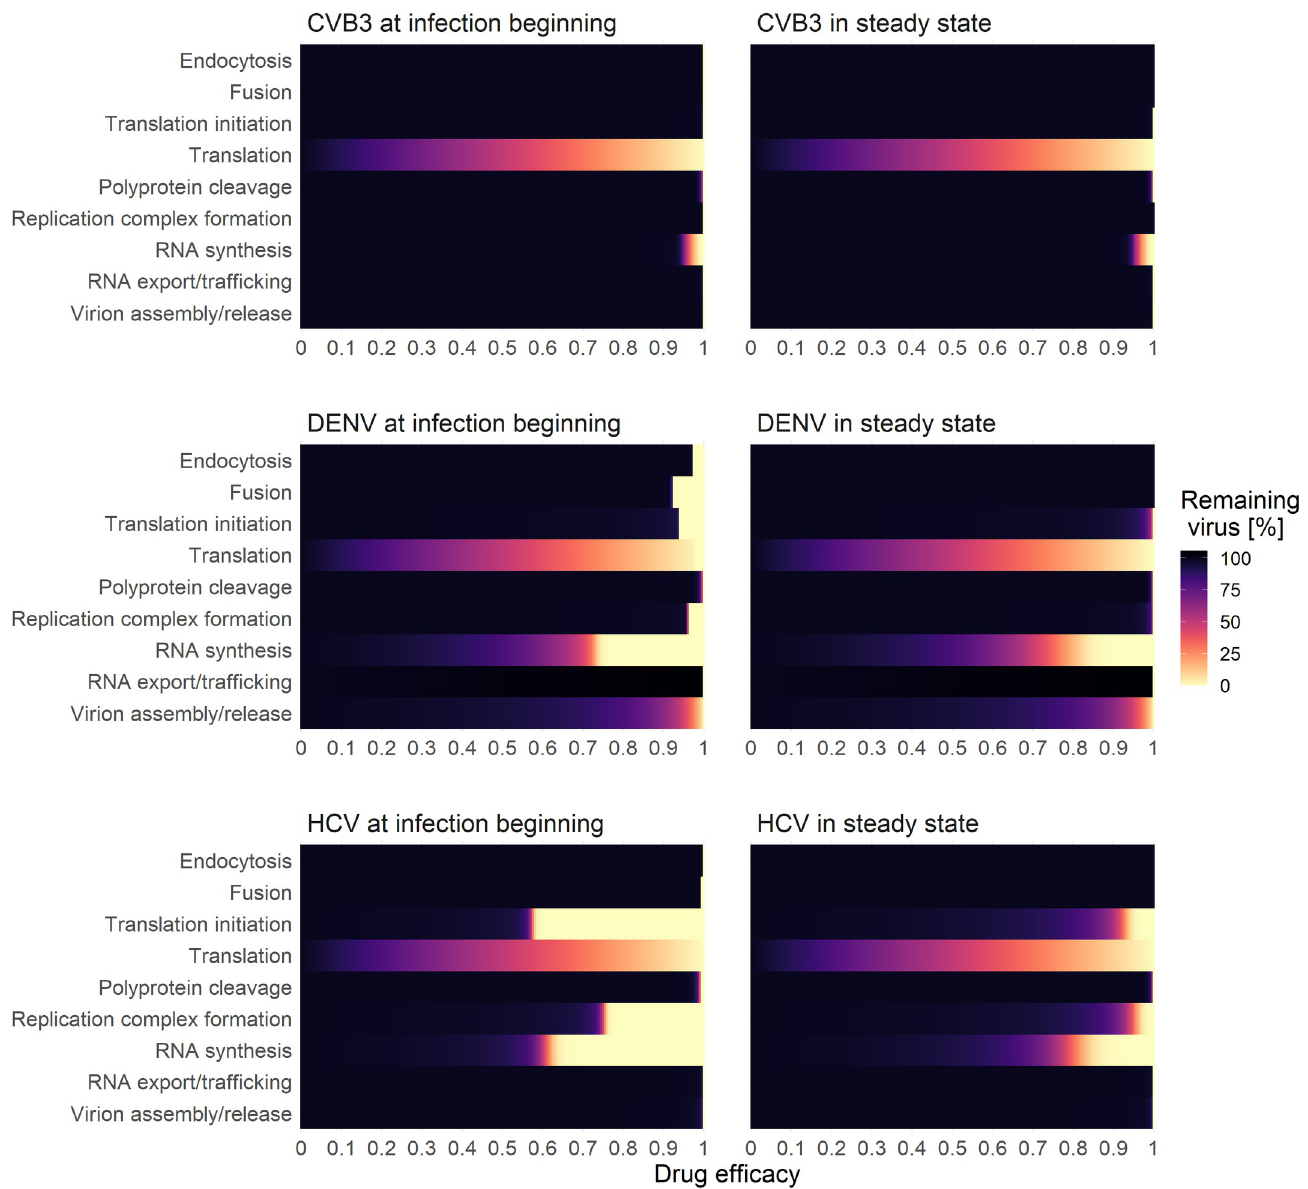
Fig 7. Effects of drug interventions applied to two different time points: at infection beginning (left) and in steady state (right). A successful drug treatment leads to more than 99% viral eradication (light yellow), while an ineffective drug treatment leads to 100% remaining virus (black).